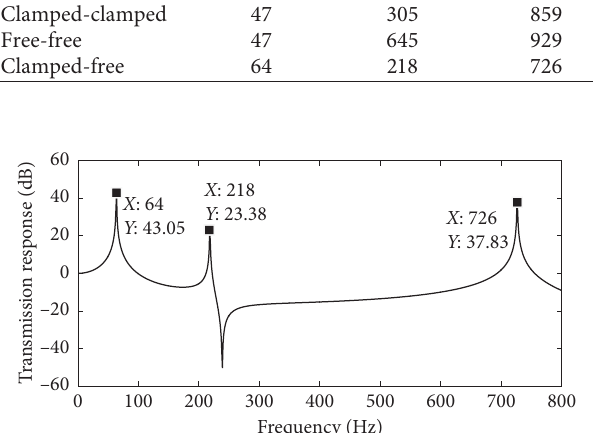
Figure 10: Transmission response of out-of-plane vibration for the single curved beam.